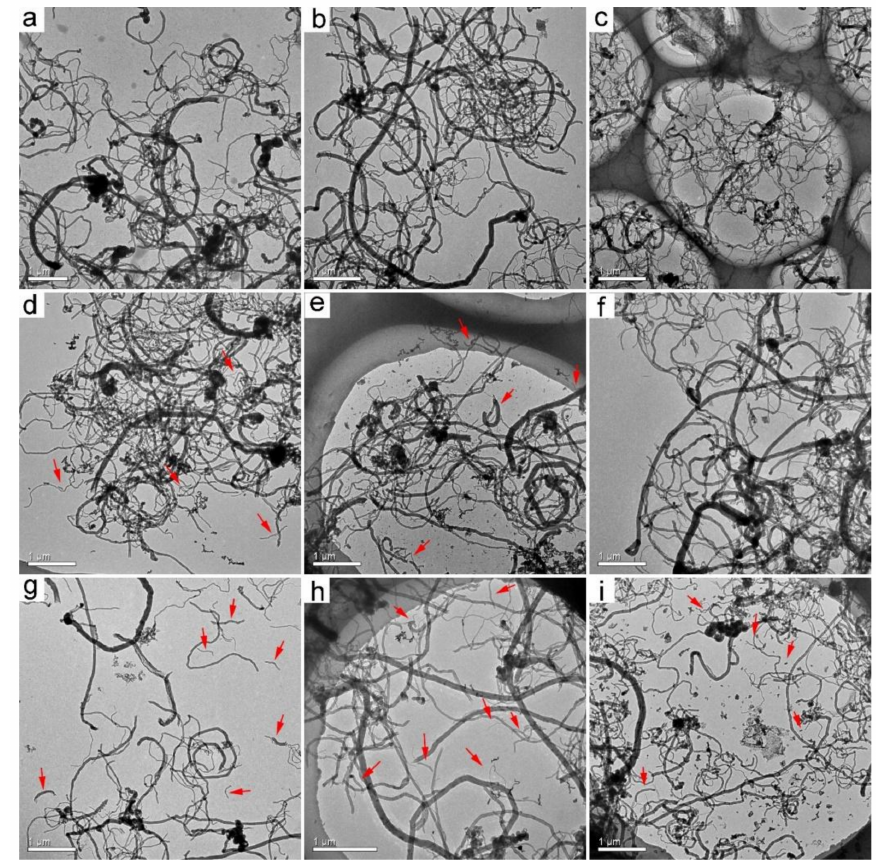
Figure 1. TEM images of pristine multiwalled carbon nanotubes (p-MWCNTs) after the incubation with P. chrysosporium . ( a ) As-prepared p-MWCNTs; ( b ) wrapped p-MWCNTs at 3 d; ( c ) wrapped p-MWCNTs at 7 d; ( d ) wrapped p-MWCNTs at 14 d; ( e ) wrapped p-MWCNTs at 30 d; ( f ) precipitated p-MWCNTs at 3 d; ( g ) precipitated p-MWCNTs at 7 d; ( h ) precipitated p-MWCNTs at 14 d; ( i ) precipitated p-MWCNTs at 30 d. Shortened p-MWCNTs are indicated by red